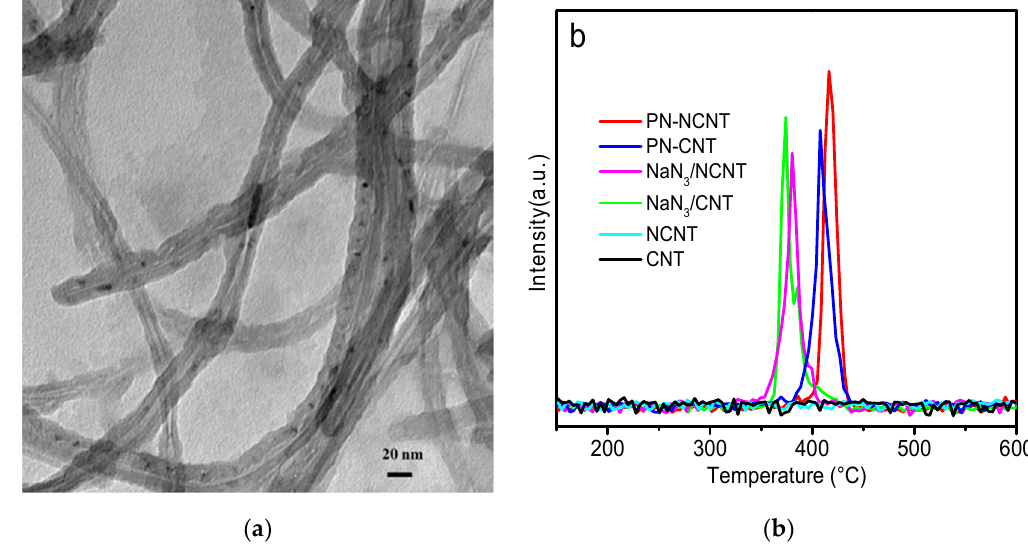
Figure 2. ( a ) TEM image of PN-NCNT and ( b ) N 14 signal from TPD scans of CNT, NCNT, NaN 3 /CNT, NaN 3 /NCNT, PN-CNT, and PN-NCNT, respectively. The curves were normalized by sample weight (see 3. Materials and Methods for abbreviations).